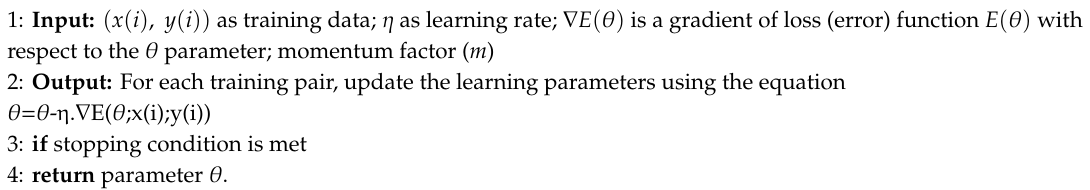
Algorithm 1 Learning Parameters Update